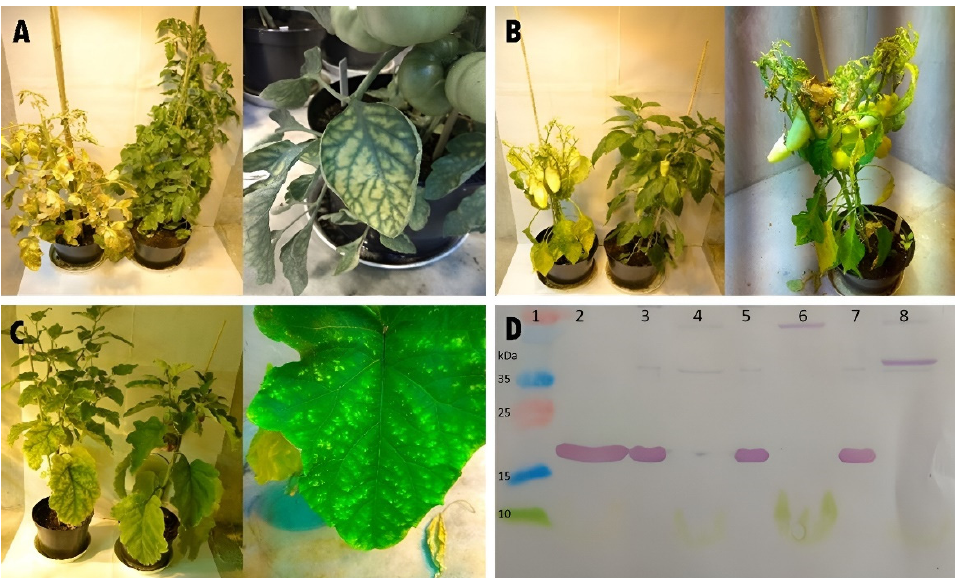
Figure 6. Symptoms of the ToMV SL-1 isolate in tomato, pepper, and eggplant. ( A )—symptomatic infected tomato plant ( left in pair) and control plant ( right in pair), and leaf mosaic symptoms ( right ), ( B )—symptomatic infected pepper plant ( left in pair), control plant ( right in pair), and leaf shedding from infected plant ( right ), ( C )—symptomatic infected eggplant plant ( left in pair), control plant ( right in pair), and mild chlorosis on leaf ( right ), ( D )—Western immunoblot detection of ToMV in plants of tomato, pepper, and eggplant. Lanes: 1—protein ladder, 2—positive control (virus), 3—infected tomato, 4—negative control tomato, 5—infected pepper, 6—negative control pepper, 7—infected eggplant, and 8—negative control eggplant.